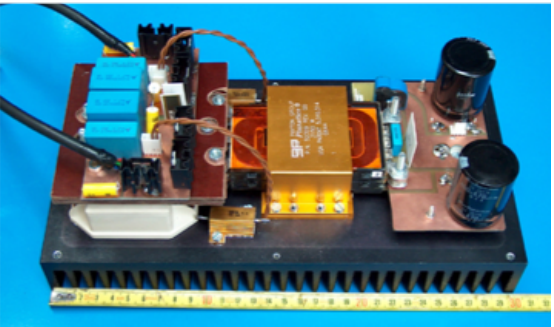
Figure 19. Laboratory prototype of the half-bridge current-source (HBCS)